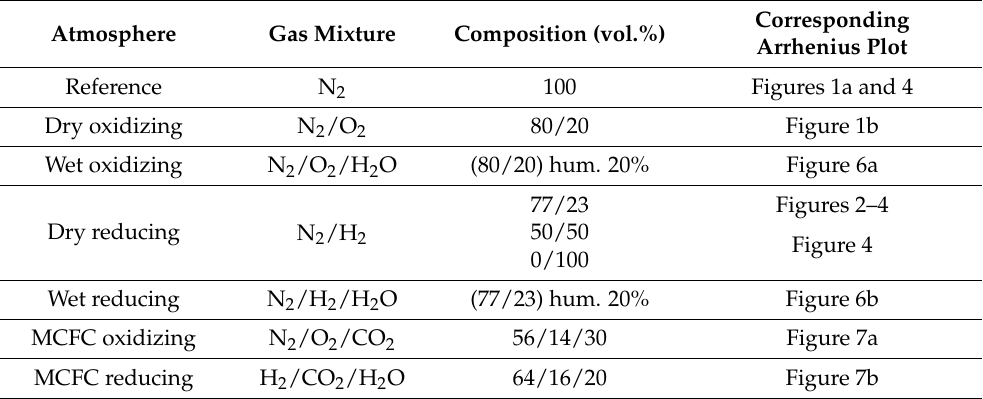
Table 1. Composition and corresponding Arrhenius plots of gaseous mixtures during EIS thermal cycling